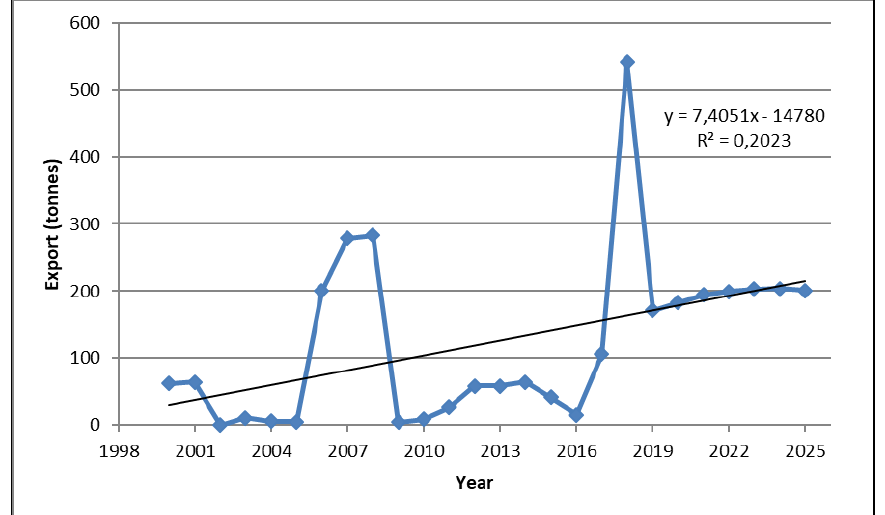
Figure 8. Turkey's oat exports (2000-2025).